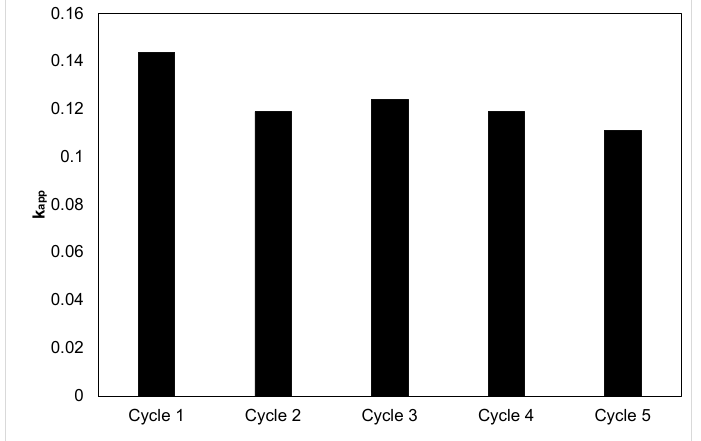
Figure 9. Effect of biochar reuse on the degradation of SMX in the combined 3D process. Conditions: [SMX]° = 500 μ g/L, [BCS_650] = 2 g/L, [Na 2 SO 4 ] = 0.1 M, j = 8 mA/cm 2 , ultrapure water.